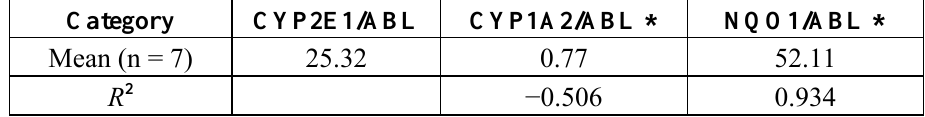
Table 2. Correlation of Expression of CYP2E1, CYP1A2, and NQO1 in AML with inv(16).